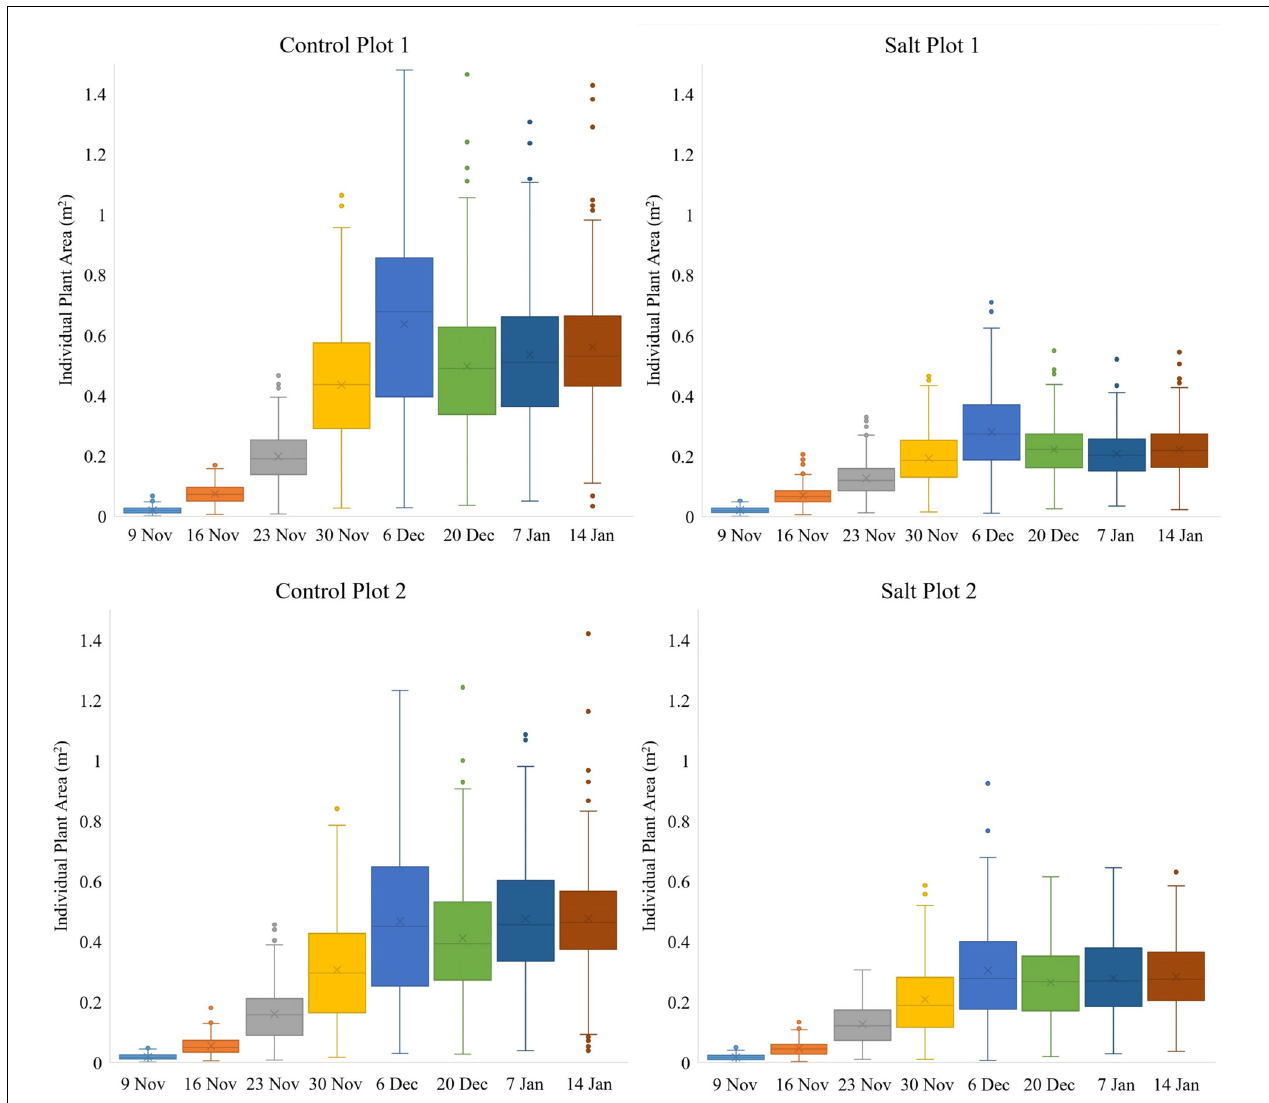
FIGURE 5 | Box-and-whisker plots, showing the variation throughout the growing season in area of individual plants, occurring within each of the four plots. The boxes cover the data from first quartile (Q1) to third quartile (Q3) (interquartile range (IQR)) with the line through each box and the X, displaying the median and mean values, respectively. The whiskers show the limits of Q1–1.5(IQR) and Q3+1.5(IQR) and dots indicate outliers from the population of